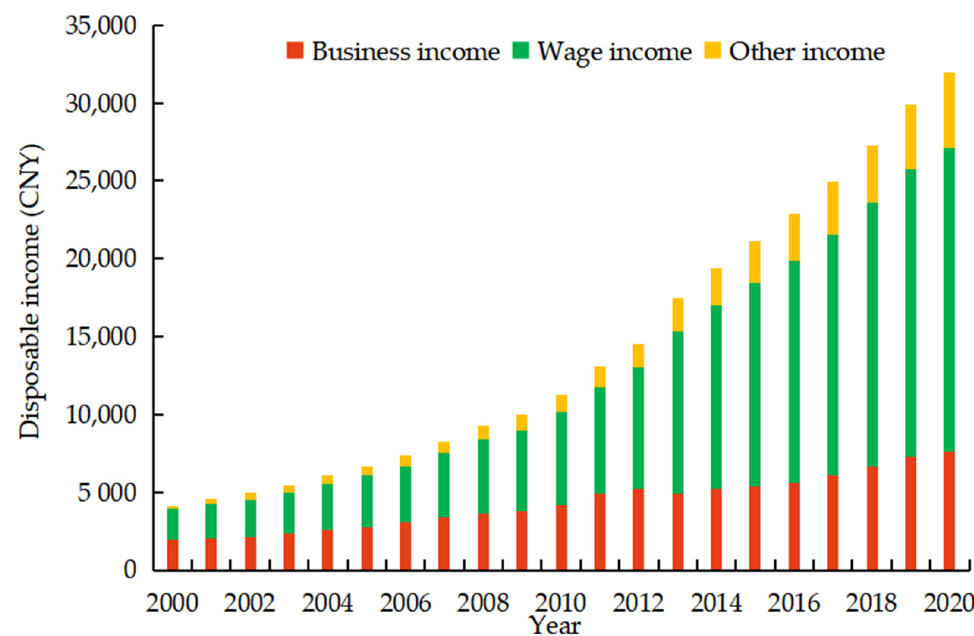
Figure 2. The composition of disposable income of farm households in Zhejiang province from 2000 to 2020.